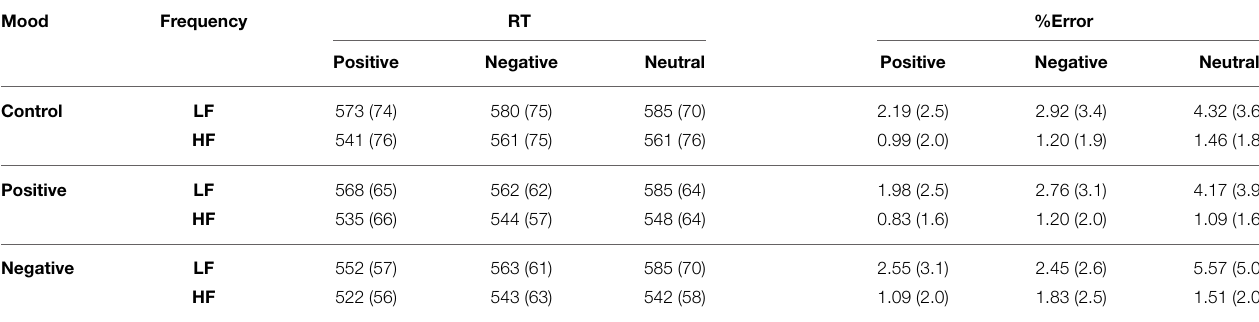
TABLE 4 | RT and %Error means (with SDs) as a function of Mood (Control, Positive, Negative), Emotion (Positive, Negative, Neutral), and Frequency (LF, HF). Mood